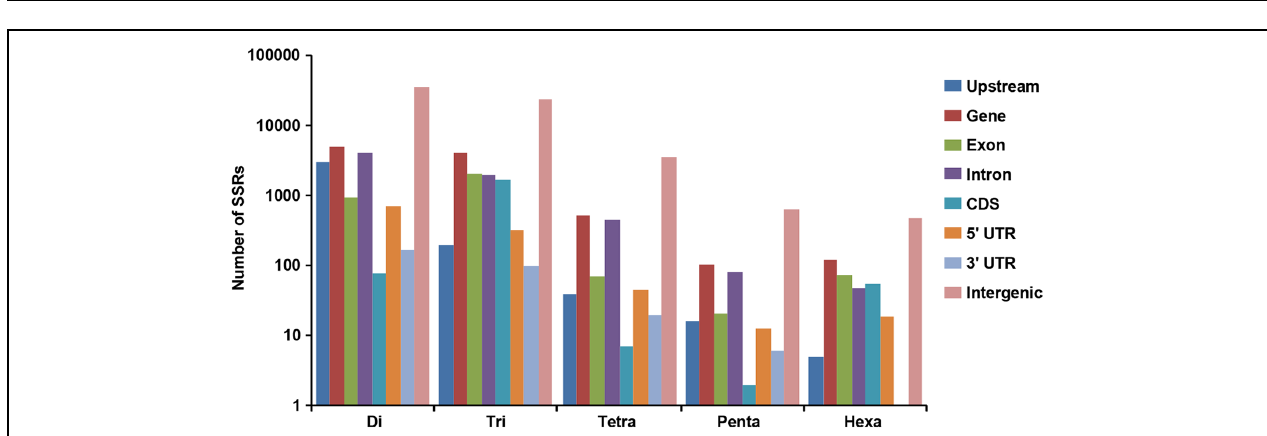
FIGURE 2 | Distribution of SSRs identified from desi and kabuli chickpea genomes in different regions of the chickpea genome. The bar graph displays the number of SSRs of different classes located in different genomic features (various gene components and intergenic regions) of the chickpea genome.